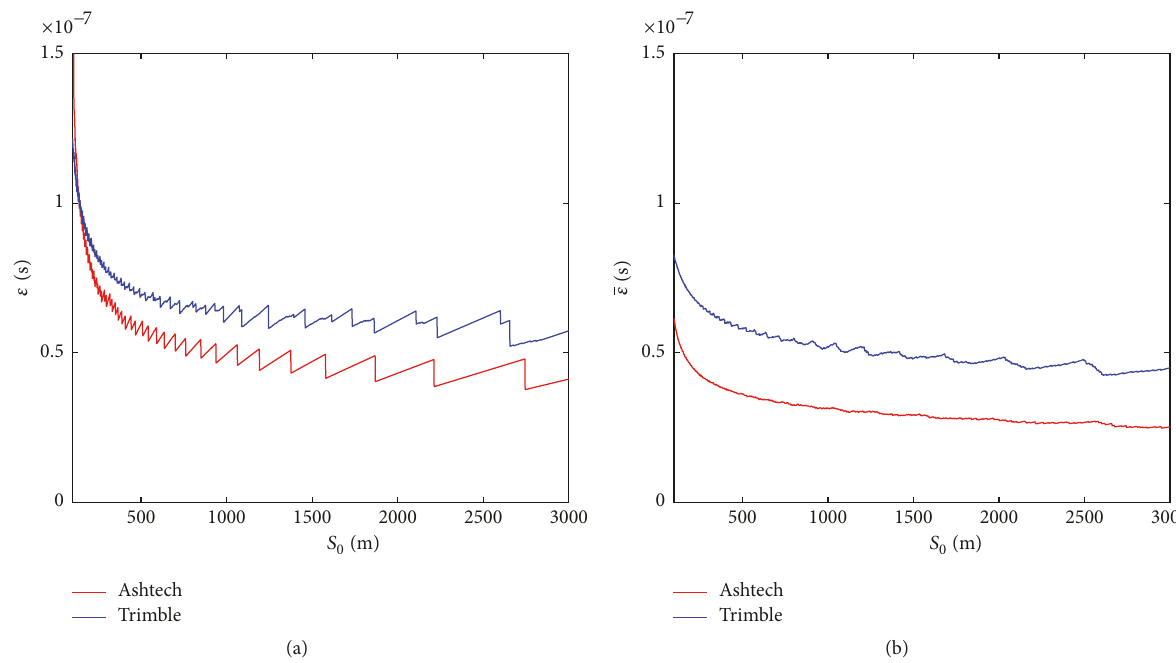
and PS with 𝑆 0 . In this figure, the width 𝑇 𝑐 of chip is set to 1/1.023𝑒6 as the chip width of max avg